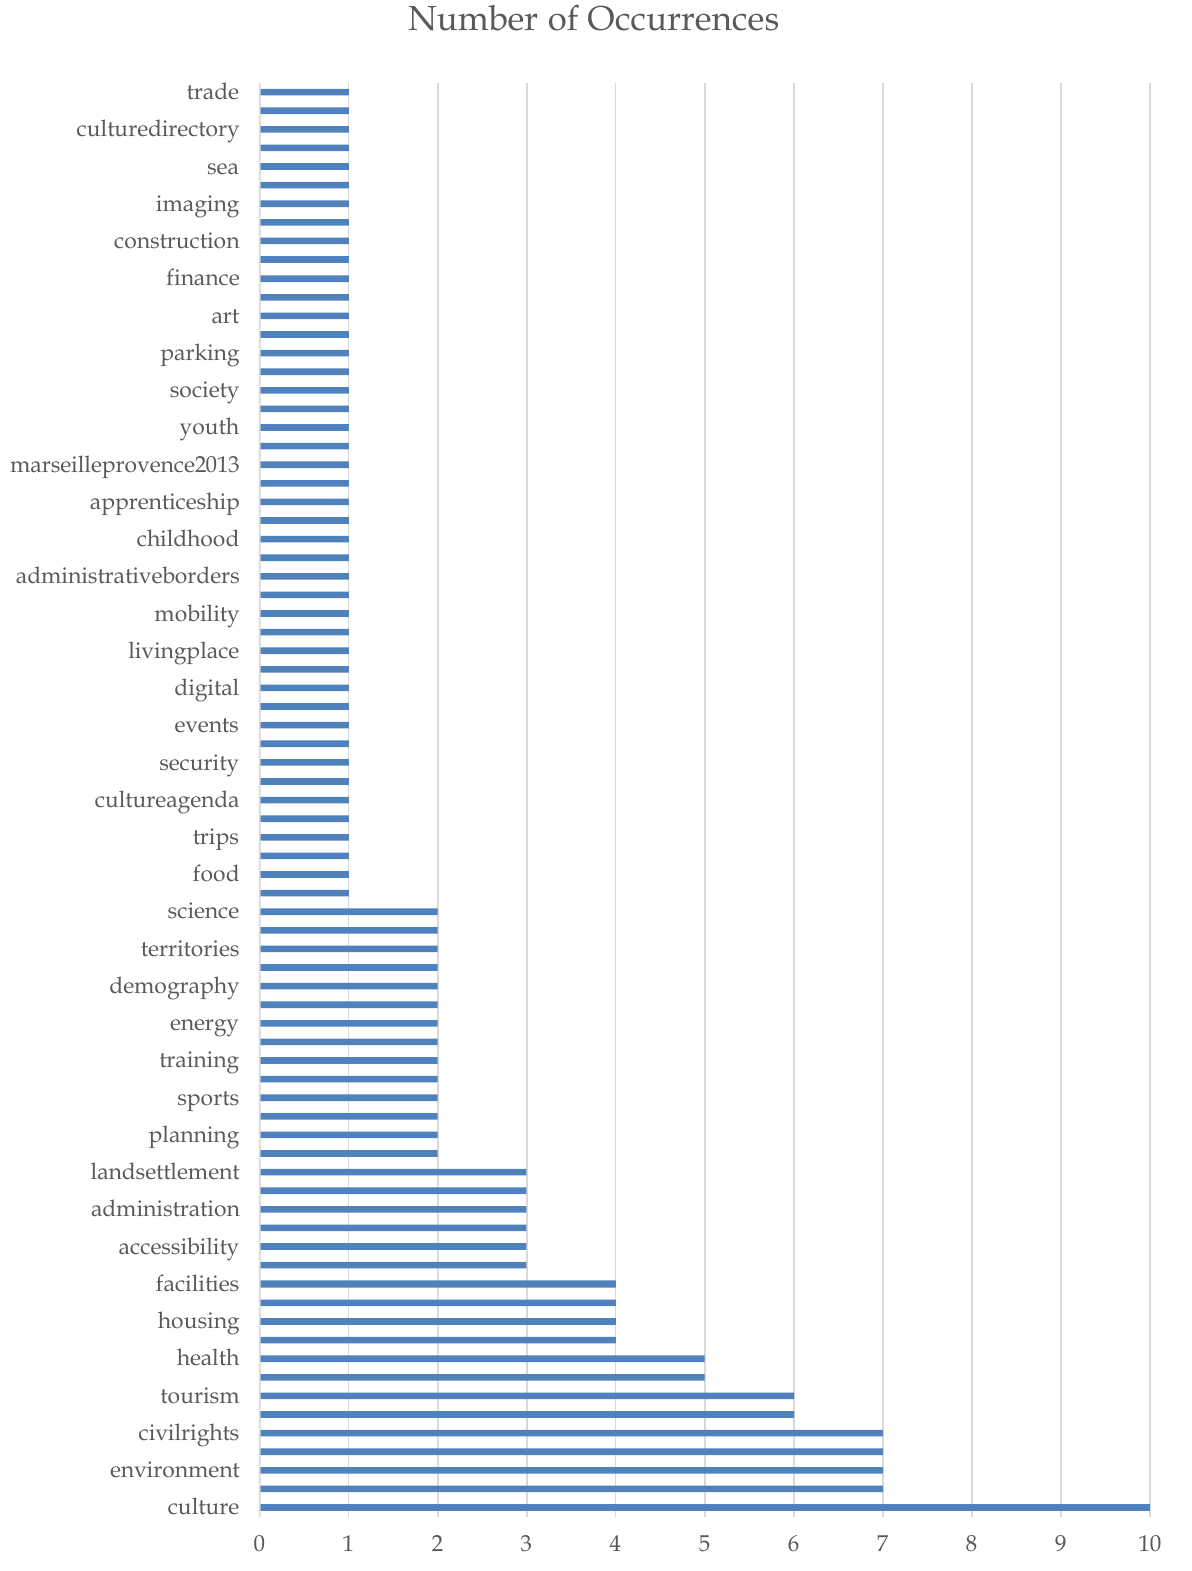
Figure 3: Categories of French Open Data Catalogs and their